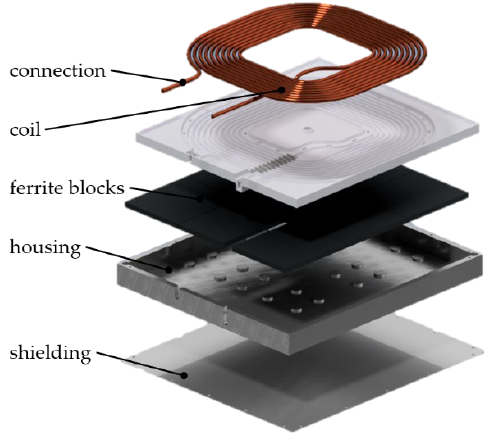
Figure 2. Composition of an IPT module.